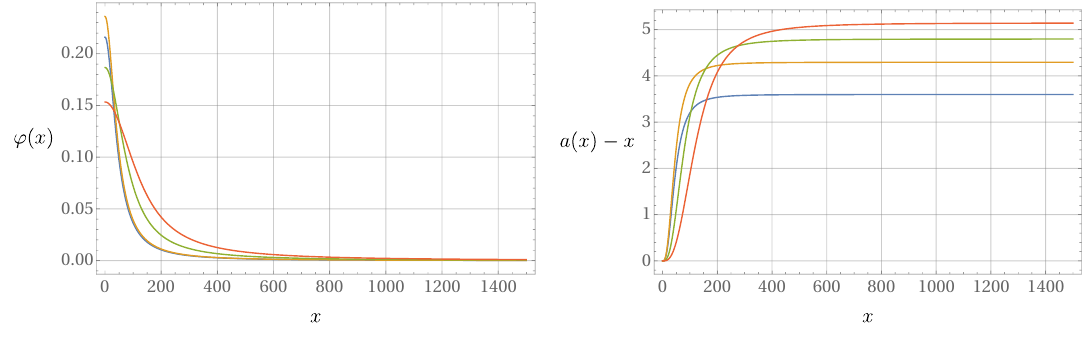
= 0 : 5 (yellow); f = 0 : 5 (blue); M S = 2 : 0 (cid:2) 10 (cid:0) 1 , M f = 10 (cid:0) 3 , g S = 0 : 95, f = 0 : 4 (red). Right panel : the f